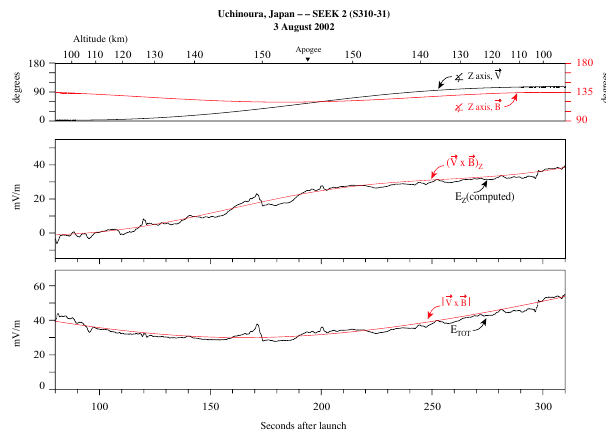
Fig. 6. The computed spin axis electric field component, E z , and the corresponding V × B component (middle panel). The total electric field and computed V × B fields (lower panel). The upper panel shows the angle between the spin axis ( z ) and the velocity vector and the angle between the spin axis ( z ) and the magnetic field vector (see scale on